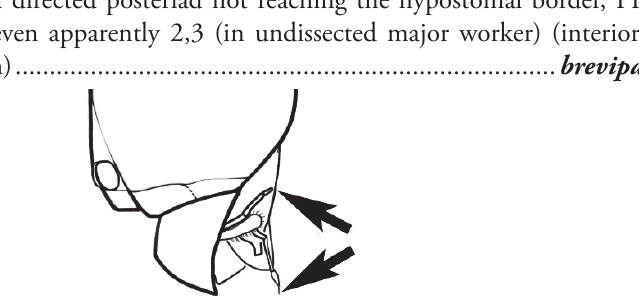
– Palps longer, extending beyond hypostomal border and PF always 6,4 ...... 90 90 Colour pale, depigmented yellow; colour of frons in full-face view often two-tone, colour lighter on lower genae (minor and media workers indistinguishable from M . sulla [ sensu stricto ]) (a few records from inland – 91 Strongly bicoloured, relatively smooth species with black, brown or varie- gated brown head, orange mesosoma and black gaster, gaster and often head (in darker morphs) with distinct bluish to violet iridescence; shorter setae on frons and pronotum may be expanded, mainly at their tip (arid inland Aus- tralia) ( JDM 1245 ) (Fig. 77a–g) .......................................